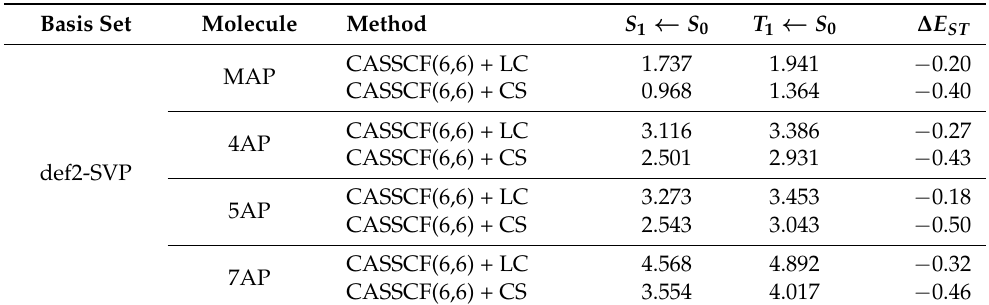
Table 4. Excited-state energies and associated ∆ E ST energy difference (all in eV) calculated with non-standard correlation functionals.